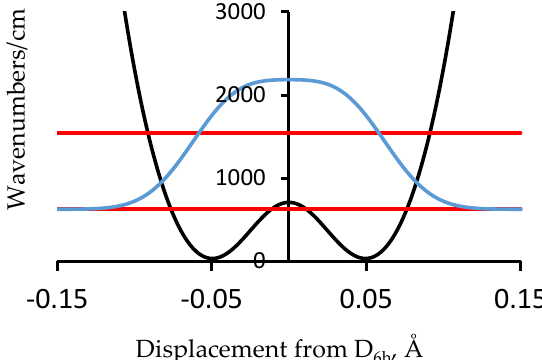
Figure 3. Computed potential energy as a function of displacement from 6-fold symmetry for [18]-annulene (black line) showing the two lowest vibrational energy levels (red) and the probability distribution for the ground state (blue) [17].